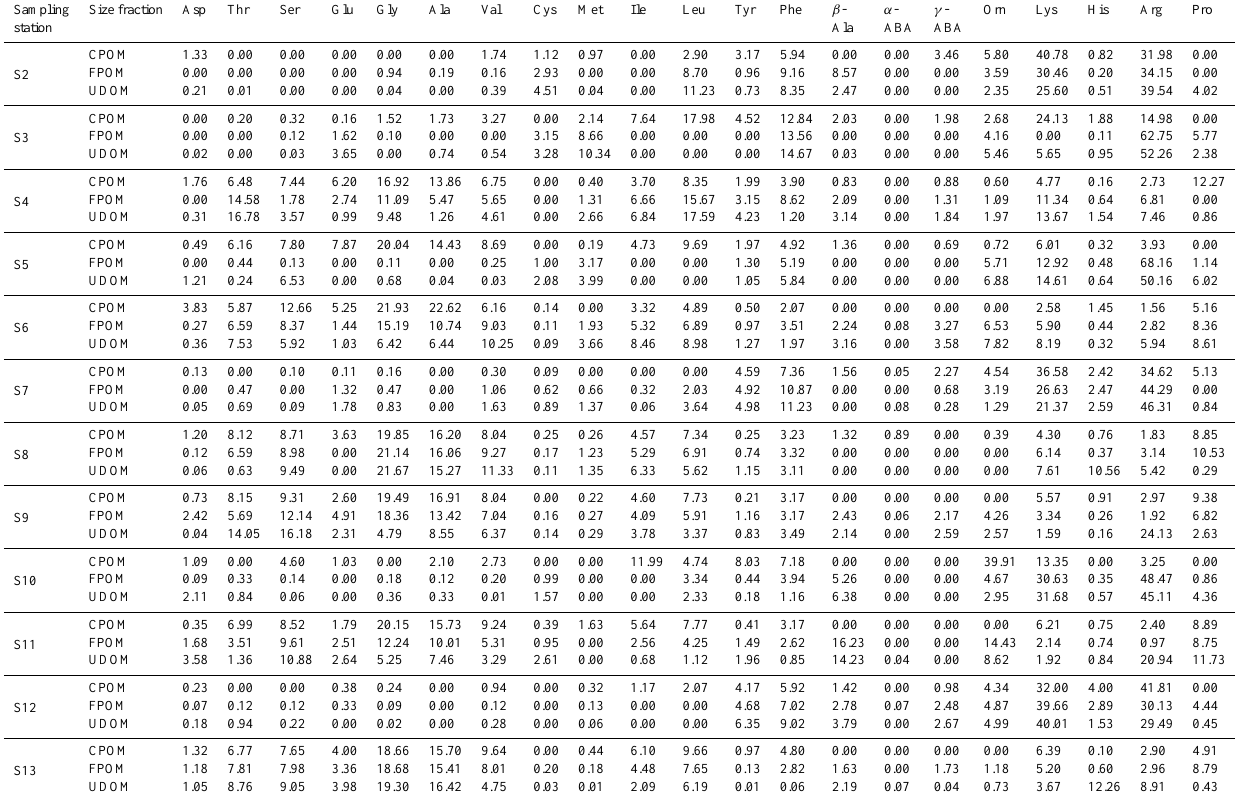
Table 4. Mole percents (%) of 21 amino acids in sediment samples of different size fractions. Sampling Sizefraction Asp